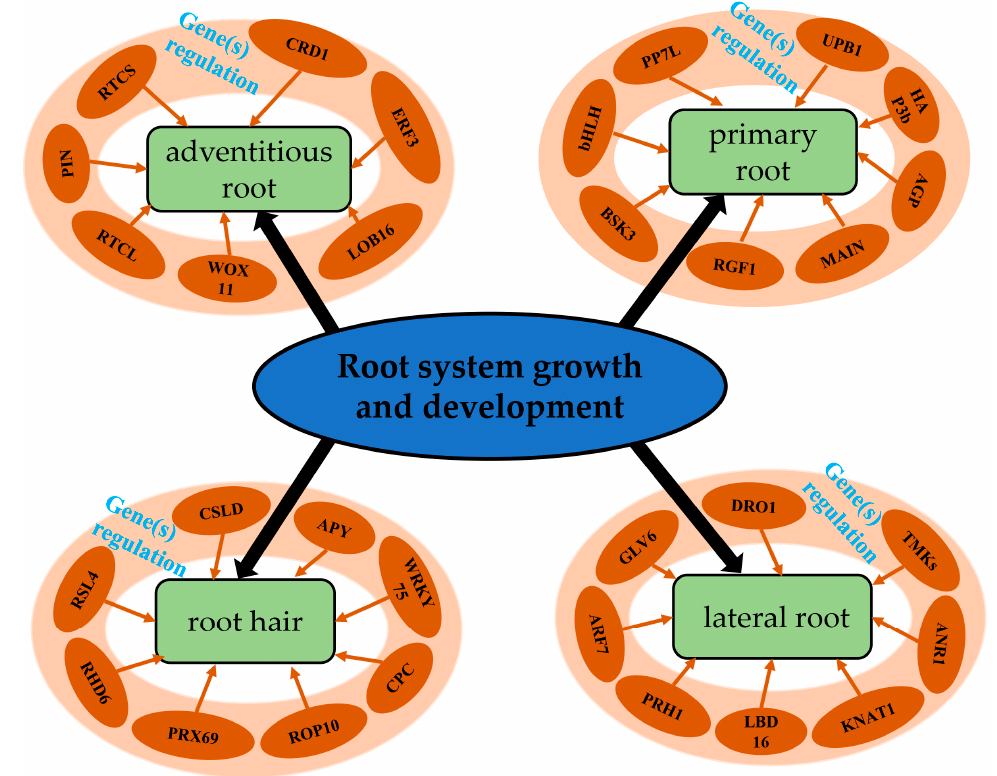
Figure 1. Major genes related to root system growth and development.